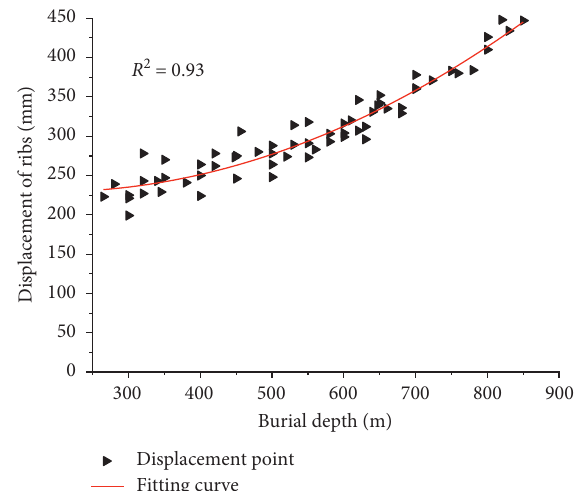
Figure 27: 10 m away from the working face.